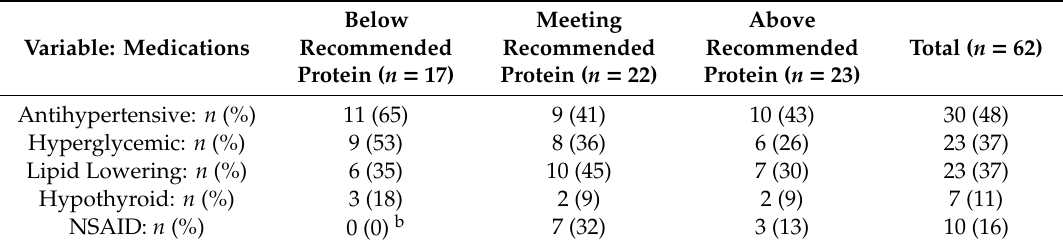
Table 1. List of medication categories and usage.